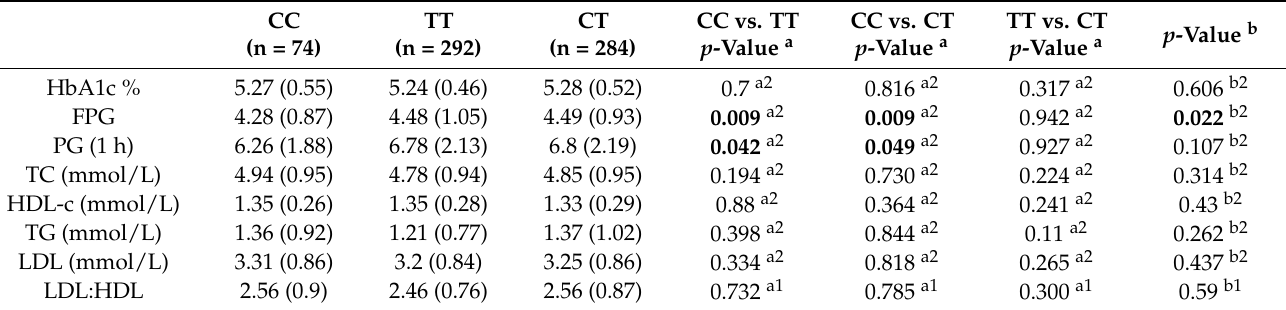
Table 3. Comparison of the mean values of clinical variables across the three genotypes of the ABCA1 C69T gene.